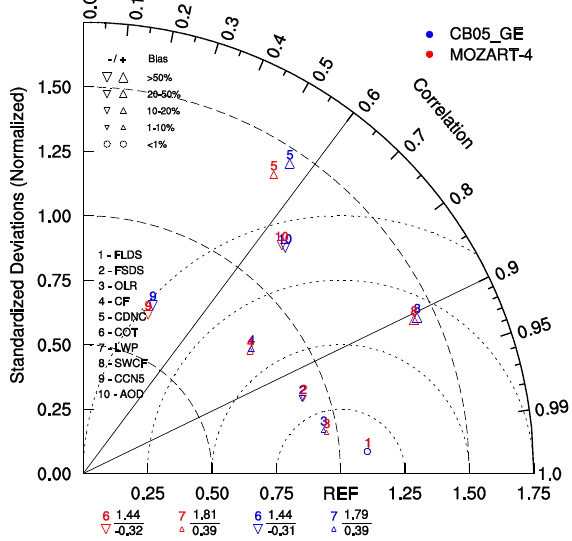
Figure 6. Taylor diagram of comparison of cloud and radiative pre- dictions between MOZART-4x and